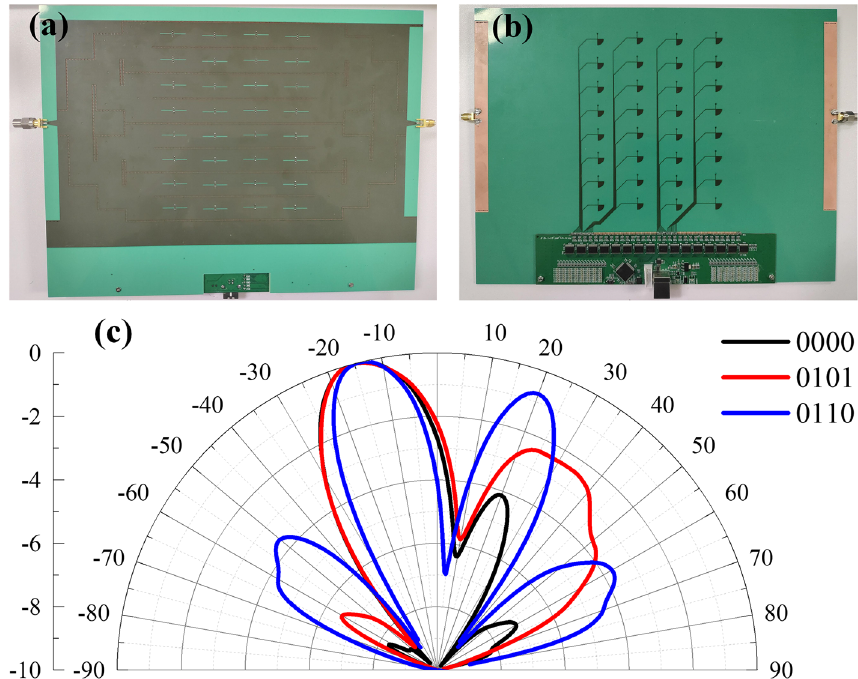
Figure 8. Overall view of the assembled tunable SIW-slot antenna array and the corresponding measured results. ( a ) Front view of the antenna. ( b ) Bottom view of the antenna. ( c ) Measured far field normalized radiation patterns of the tunable designed SIW-slot antenna array in several on-off states of diodes ( ϕ = 90